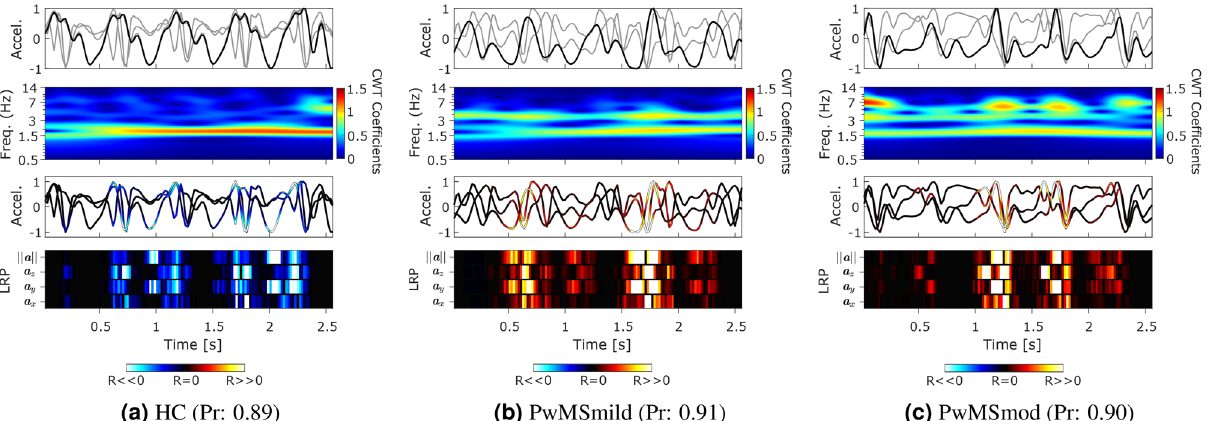
Figure 5. Visualisation of the average gait signal through the LRP-CWT analysis framework. Representative average epochs (n=128 samples, 2.56 [s]) were first created using Dynamic Time Warping Barycenter Averaging (DBA) independently for sets of correctly classified epochs from HC, PwMSmild, and PwMSmod subject groups. (Pr; represents the DCNN posterior probability for that